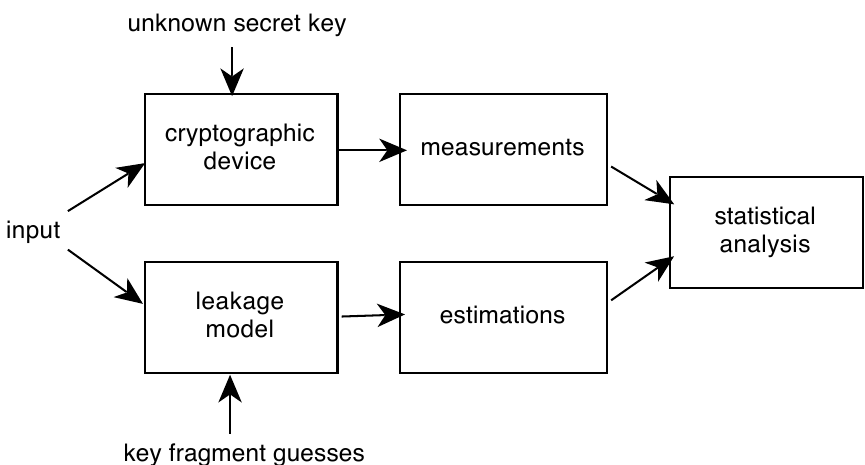
Figure 1. Statistical SCA